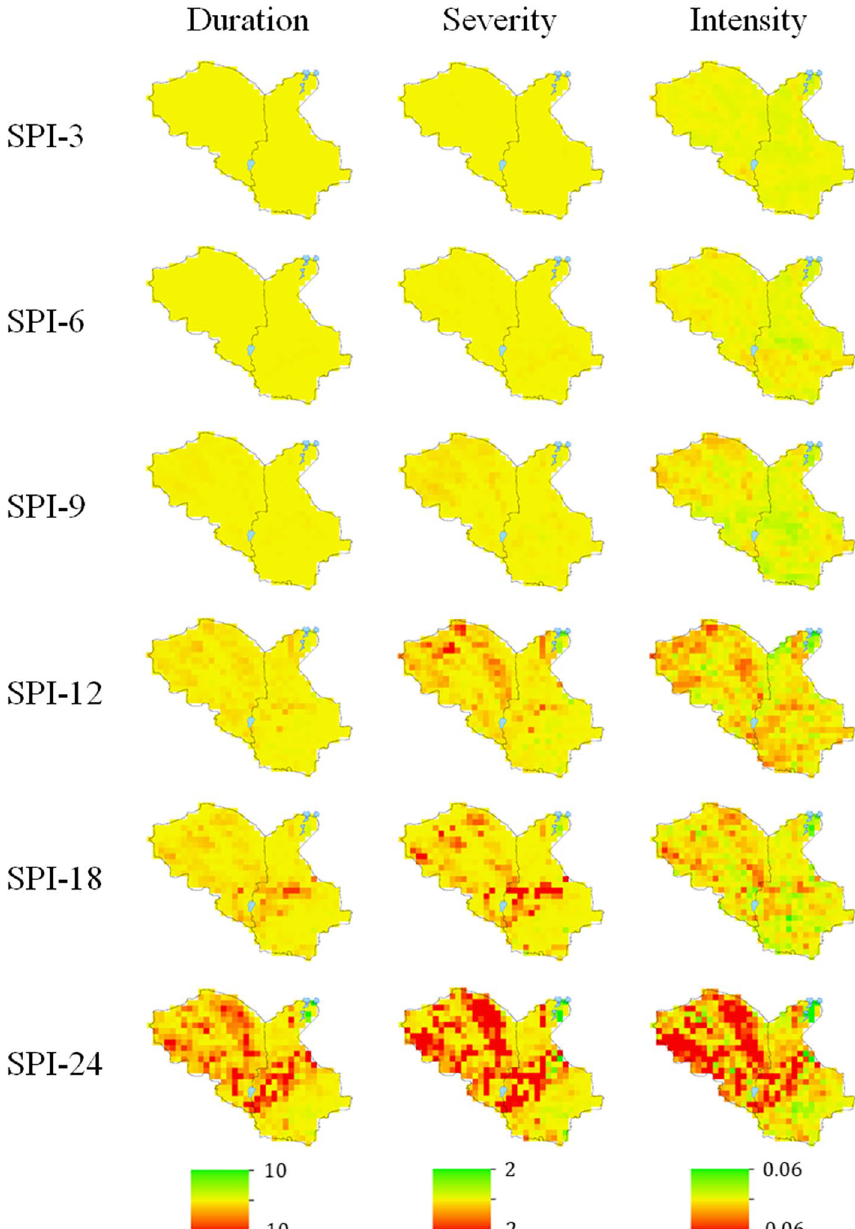
Fig. 9 Sen’s slopes for DD, DS, and